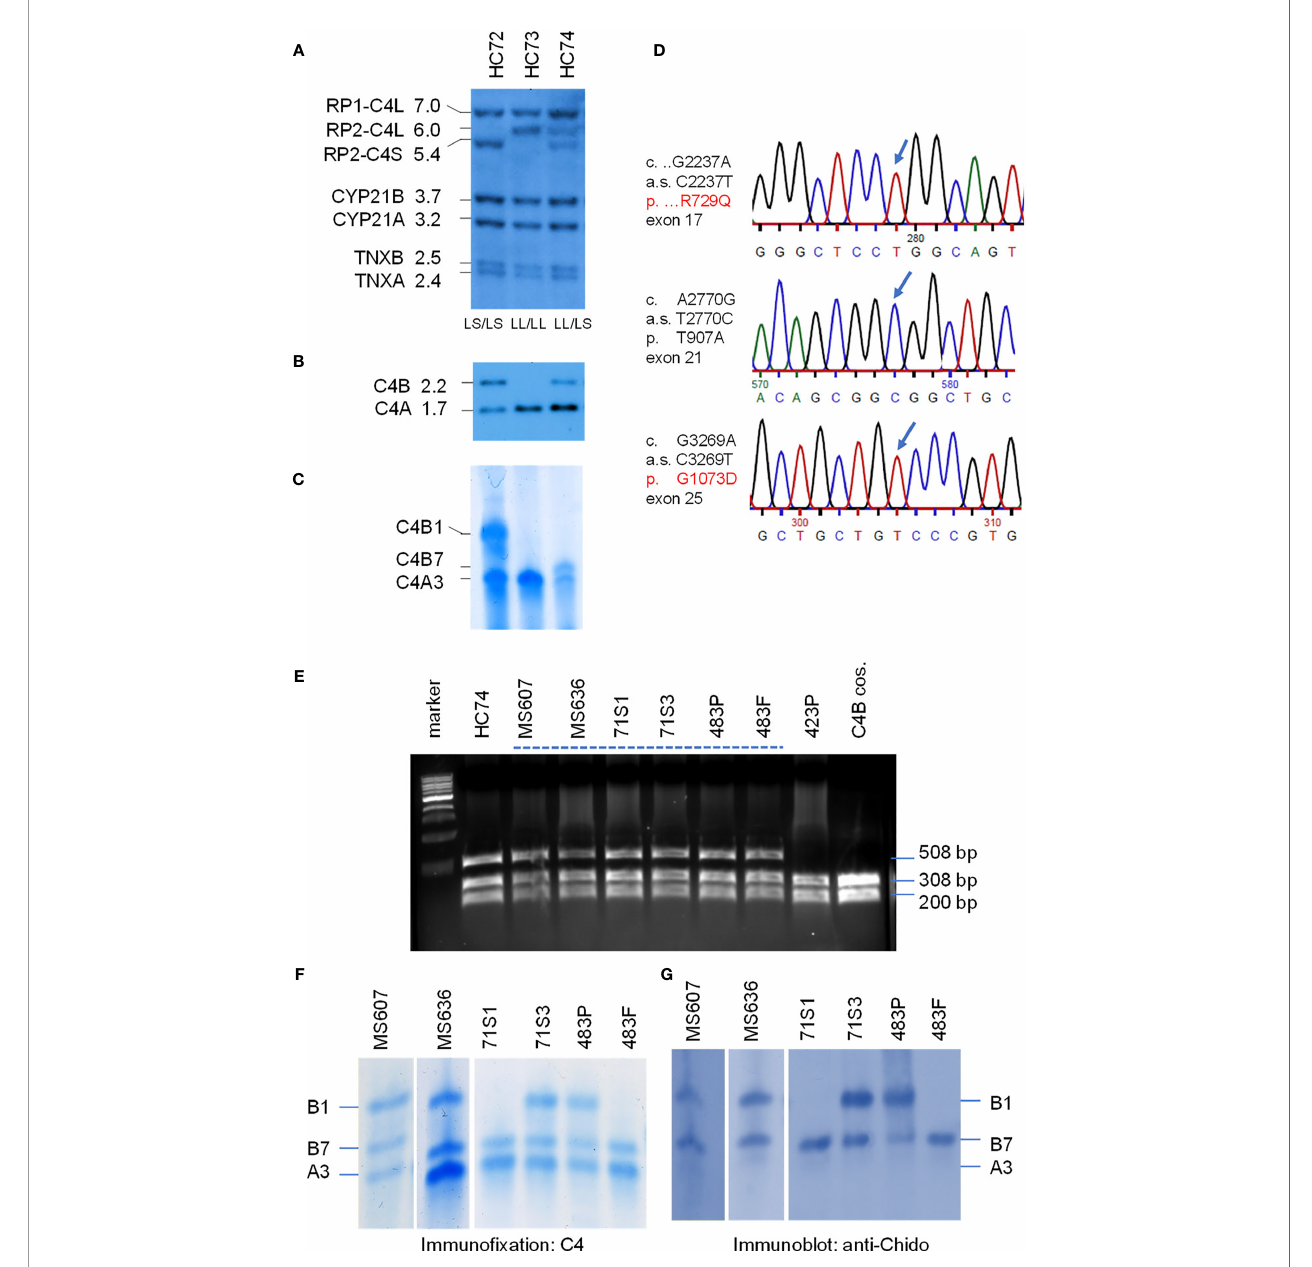
FIGURE 3 | Genotype and phenotype analyses of the fast migrating C4B7 (HC74). (A) Southern blot analysis for RP-C4-CYP21-TNX (RCCX) modular structures of three White healthy subjects. Genomic DNA samples were digested with Taq I restriction enzyme, blotted to nylon membrane and hybridized to 32 P-labeled speci fi c genomic probes spanning the RCCX to characterize the quantitative variation of C4 long or short genes linked to RP1 or RP2 , the relative dosage of CYP21B and CYP21A , and the relative dosage of TNXA and TNXB . (B) Psh AI/ Pvu II Southern blot with radioactive C4d probe to determine the relative dosage of C4B and C4A in the same subjects. (C) Immuno fi xation of C4A and C4B protein from EDTA-plasma resolved by high voltage agarose gel electrophoresis and reacted with polyclonal antiserum against human C4. (D) DNA sequences showing three variants identi fi ed for HC74 that contributed to R729Q ( upper panel ), T907A ( middle panel ) and G1073D ( lower panel ). (E) Nci I RFLP to detect DNA sequence change for R729Q in C4 genes of eight human subjects and a negative control. DNA fragments of 508-bp from both C4A and C4B genes were ampli fi ed, digested with Nci I and resolved by agarose gel electrophoresis. The DNA samples for the Q729 variant were resistant to the Nci I digest. (F, G) Immuno fi xation (F) and immunoblot (G) of C4 protein allotypes from six samples with C4B7 identi fi ed by PCR in panel (E) . Fast migrating B7 allotypes were observed in all six samples and they reacted with anti-Chido monoclonal antibodies which are mostly associated with C4B. Notice that the C4A3 protein shown in panel (F) did not react with the anti-Chido antibody in panel (G) . The GenBank accession number for the DNA fragment containing sequence with R729Q in HC74 is